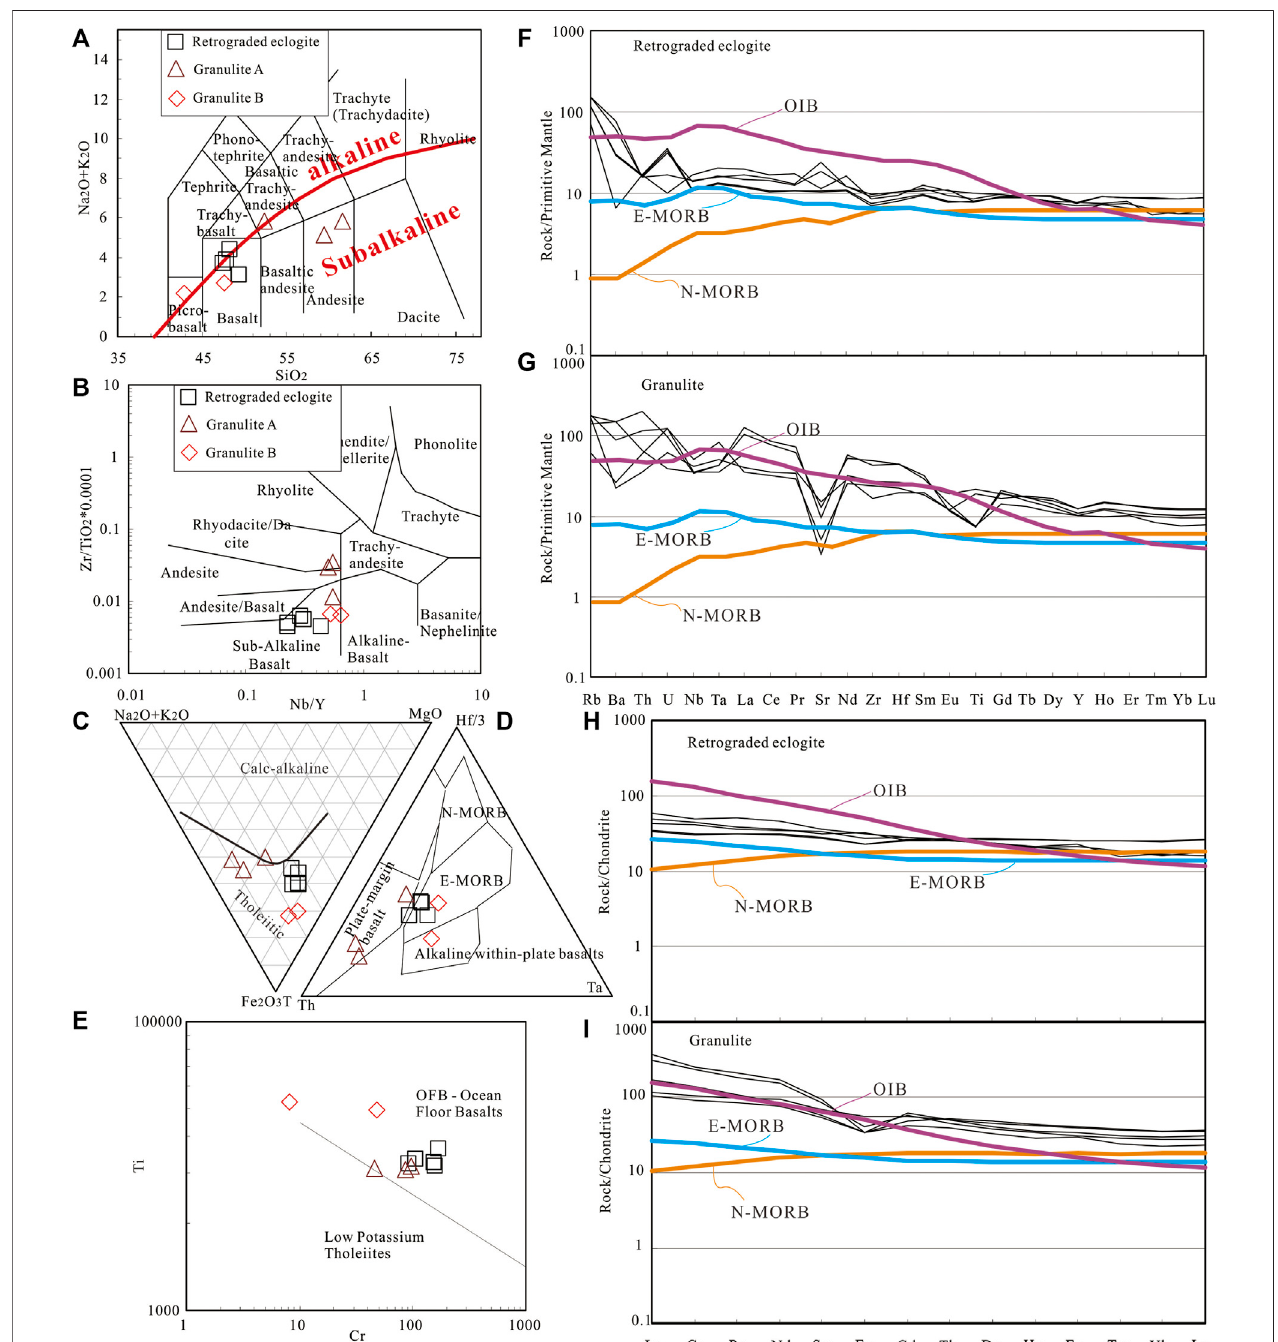
FIGURE 4 | Major and trace element plots of the studied high-grade rocks from the Wuyi terrane of the Cathaysia Block. (A) is after Middlemost (1994); (B) is after Winchester and Floyd (1977); (C) is after Irvine and Baragar (1971); (D) is after Wood (1980); (E) is after Pearce (1975); Primitive mantle and Chondrite normalization factors, as well as the values for N-MORB, E-MORB and OIB are after Sun and McDonough (1989).